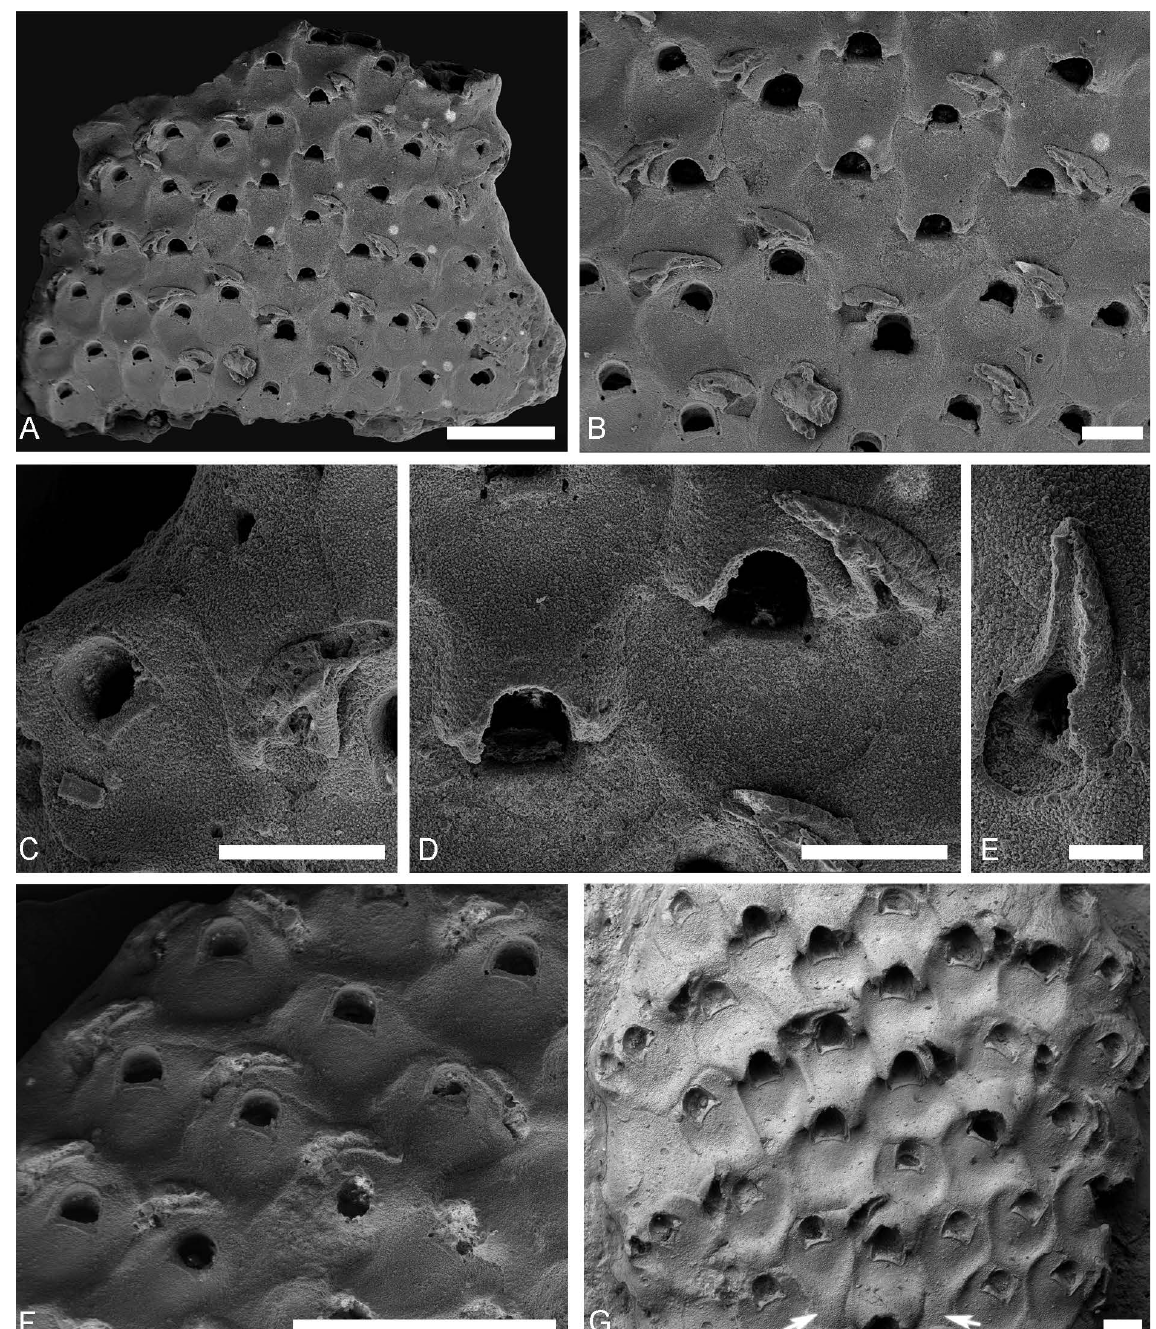
Fig. 12. Rhagasostoma gibbosum (Marsson, 1887). A–F . Early Maastrichtian, Saturn quarry near Kronsmoor, Schleswig-Holstein, Germany. A–E . SMF 29906. A . Overview of erect bifoliate colony. B . Ovicellate and non-ovicellate autozooids and avicularia. C . Autozooid, avicularium with wedge-like structure and kenozooid. D . Ovicellate autozooids and avicularia with wedge-like structure. E . Avicularium with broken wedge-like structure. F . SMF 29907, autozooids and avicularia. G . SM B36679, Upper Chalk, early Maastrichtian, Ostrea lunata Zone, Trimingham, Norfolk, England, UK. Ovicellate and non-ovicellate autozooids, some with gymnocyst (arrowed), avicularia and kenozooids. Scale bars: A, F = 1 mm; B–D = 300 µm; E = 100 µm; G = 200